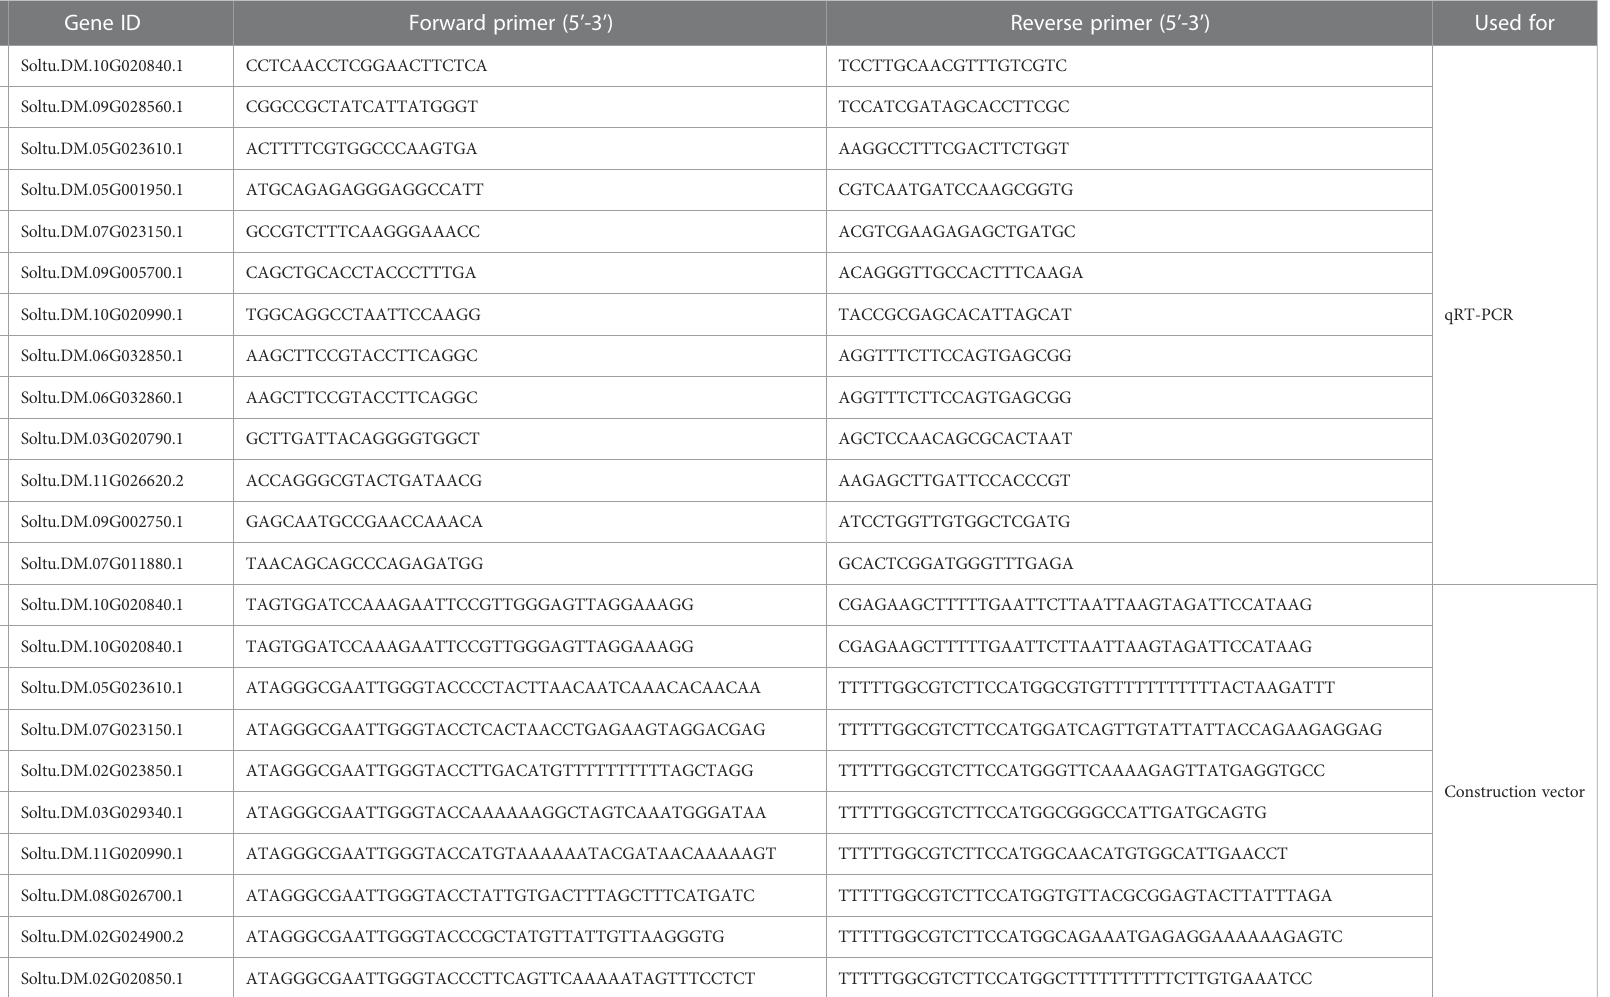
TABLE 1 The primer sequences for qPCR and constructing